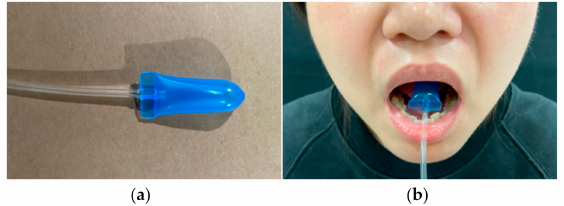
Figure 1. Tongue pressure measurement: ( a ) air bulb, ( b ) placement of the bulb.